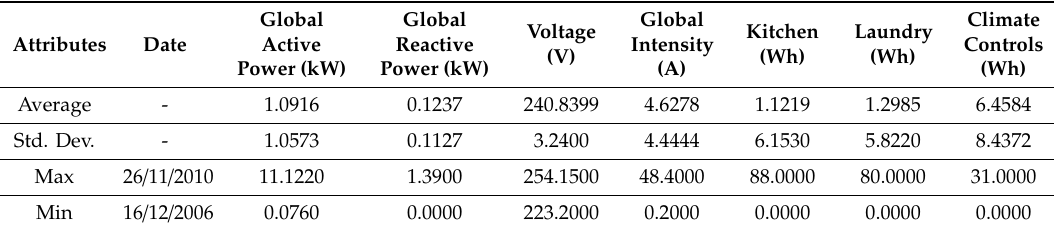
Table 2. The attributes and statistics of the UCI household electric power consumption